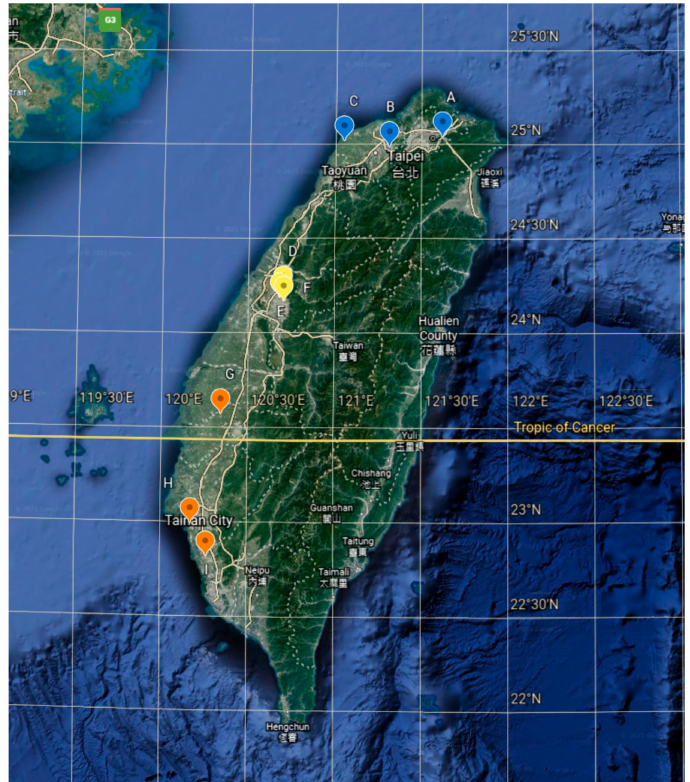
Figure 1. Location of 9 solar PV power plants in Taiwan